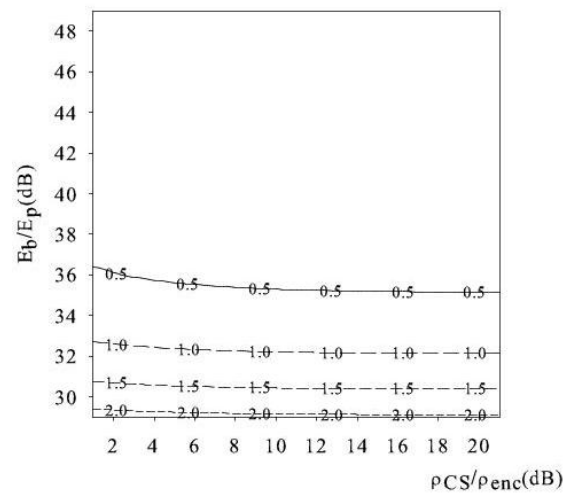
Figure 4. Ratio E in-net / E off-net versus the ratio ρ CS / ρ enc and E b / E p , N = 128 × 128, L =